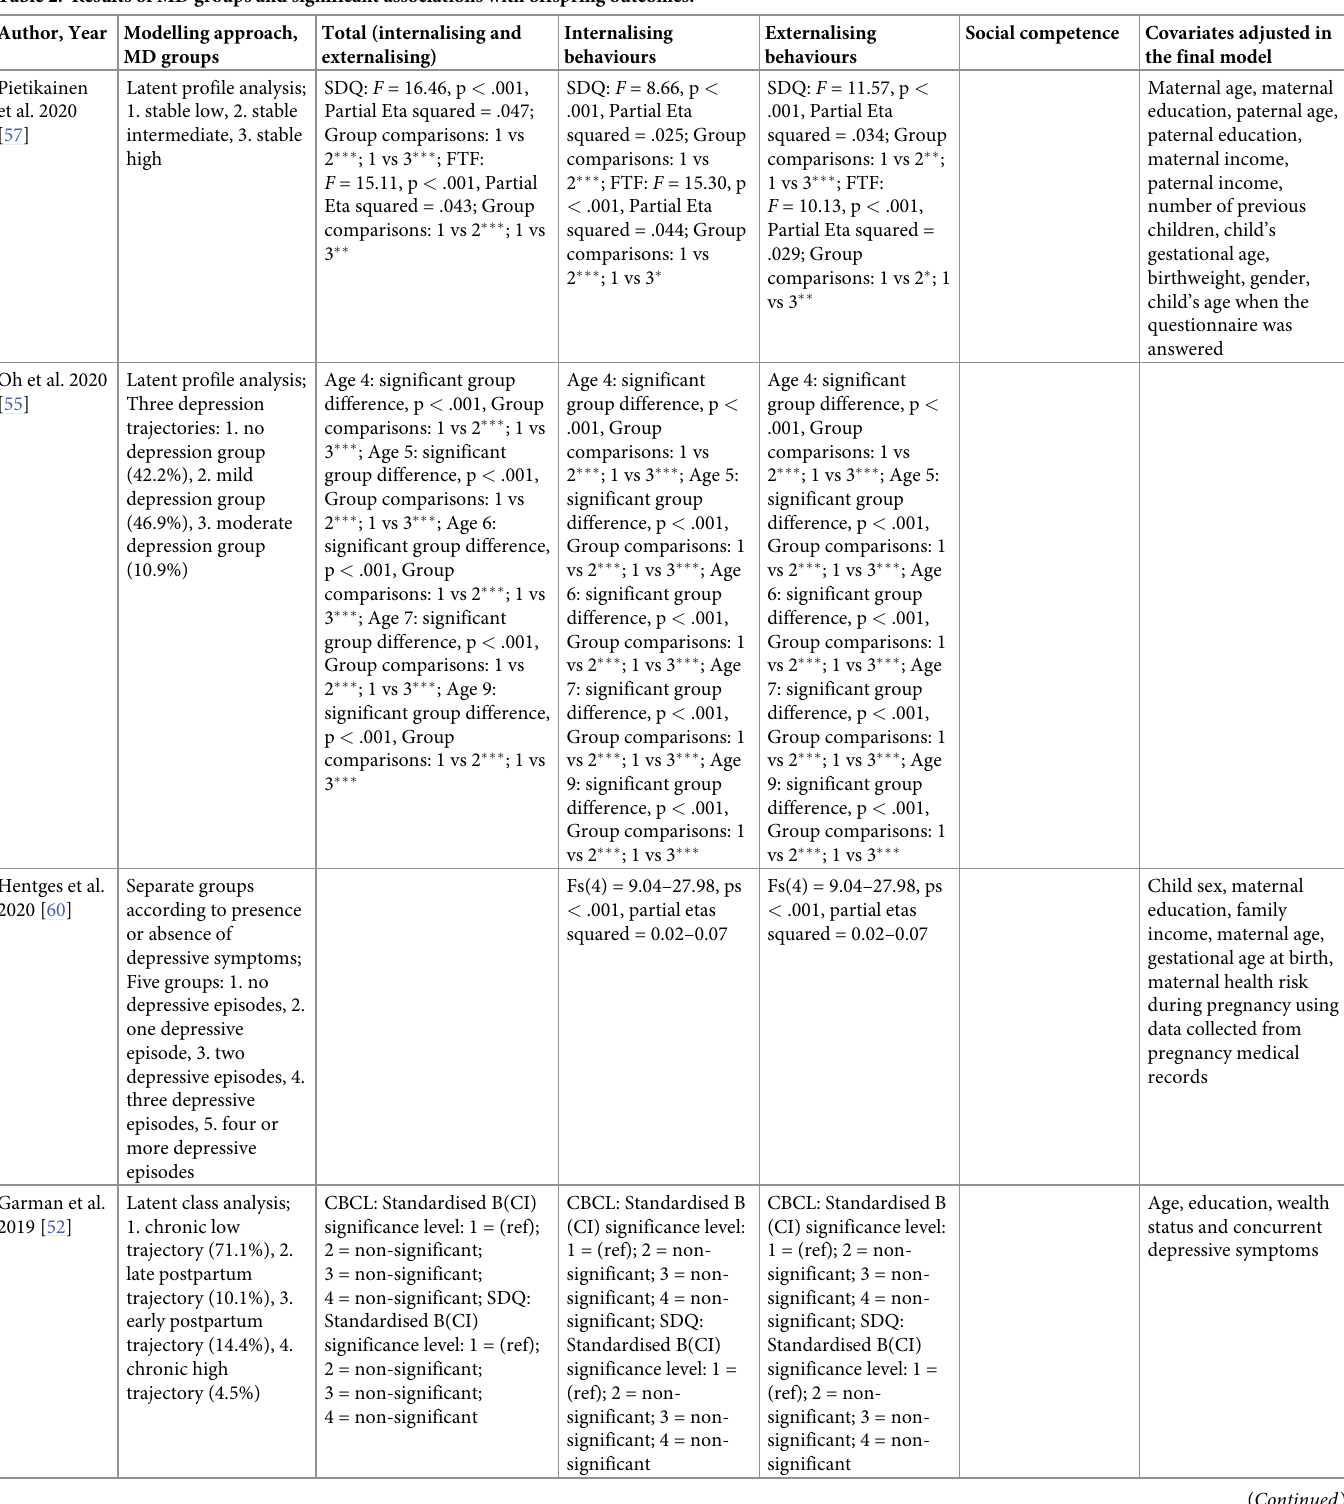
Table 2. Results of MD groups and significant associations with offspring